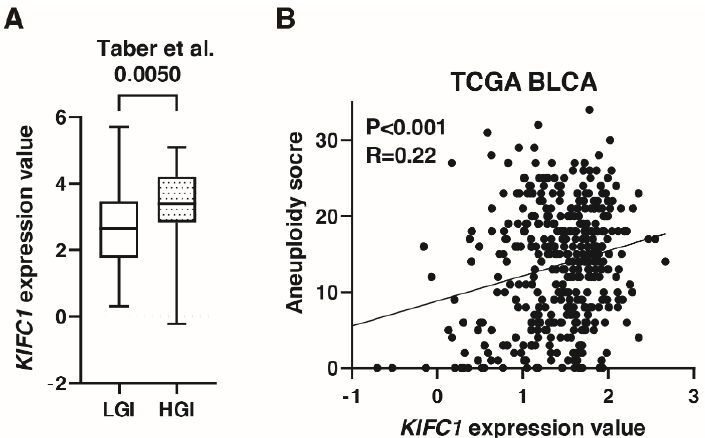
Figure 5. KIFC1 is associated with genomic instability in bladder cancer (BC). ( A ) Box plot of KIFC1 expression in low and high genomic instability groups in the study by Taber et al. [22] ( B ) The correlation between KIFC1 expression and aneuploidy score in TCGA BLCA. Spearman’s correlation coefficients and p -values are indicated.